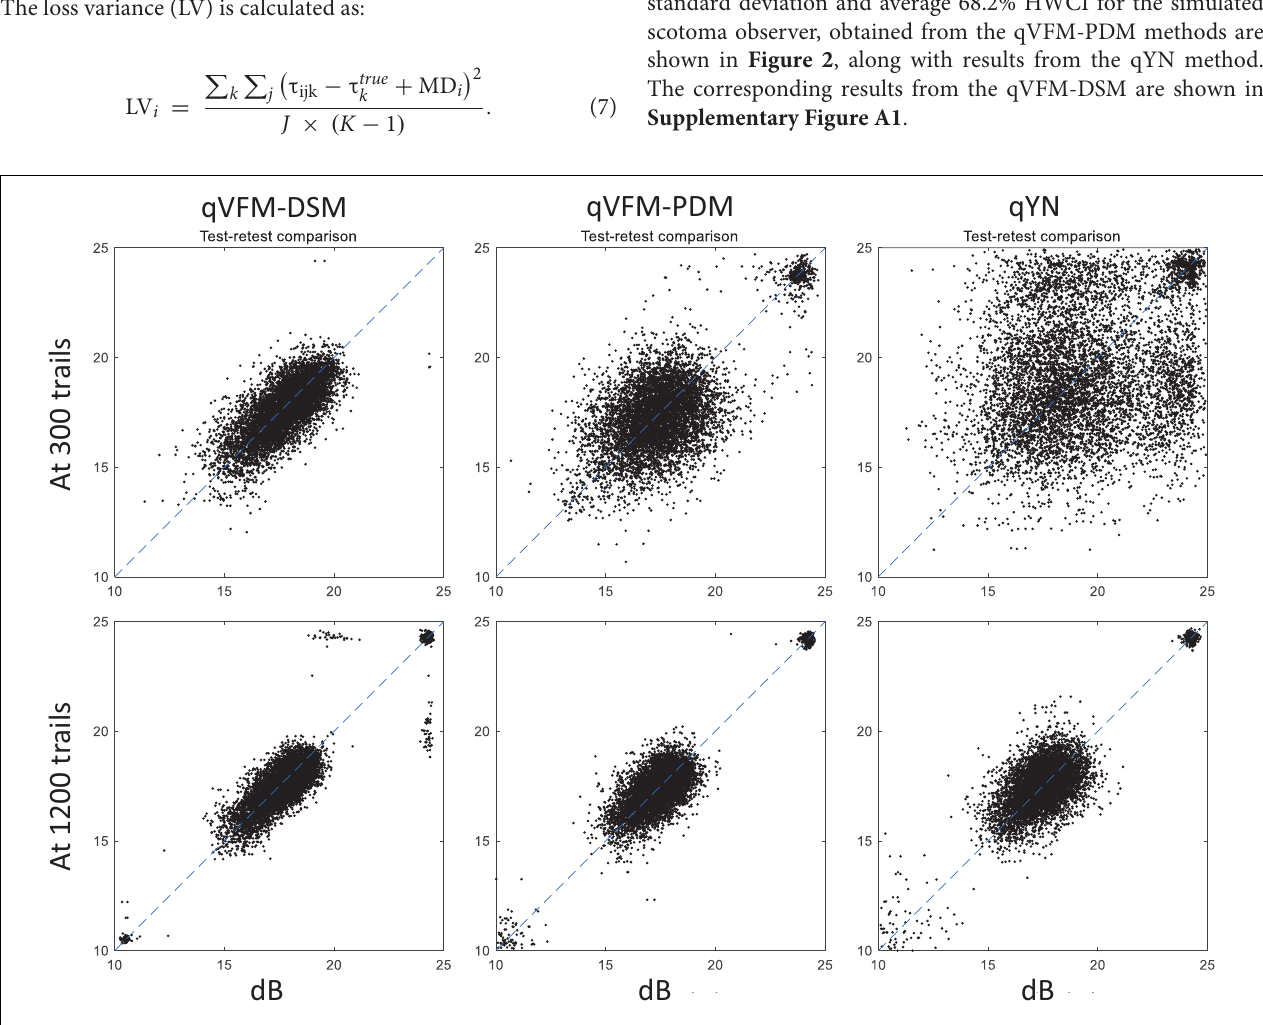
FIGURE 7 | Performance II of the three methods in estimating VFM of the simulated glaucoma observer. Test-retest comparison of the estimated light sensitivities from repeated 200 runs at 300 and 1,200 trials.